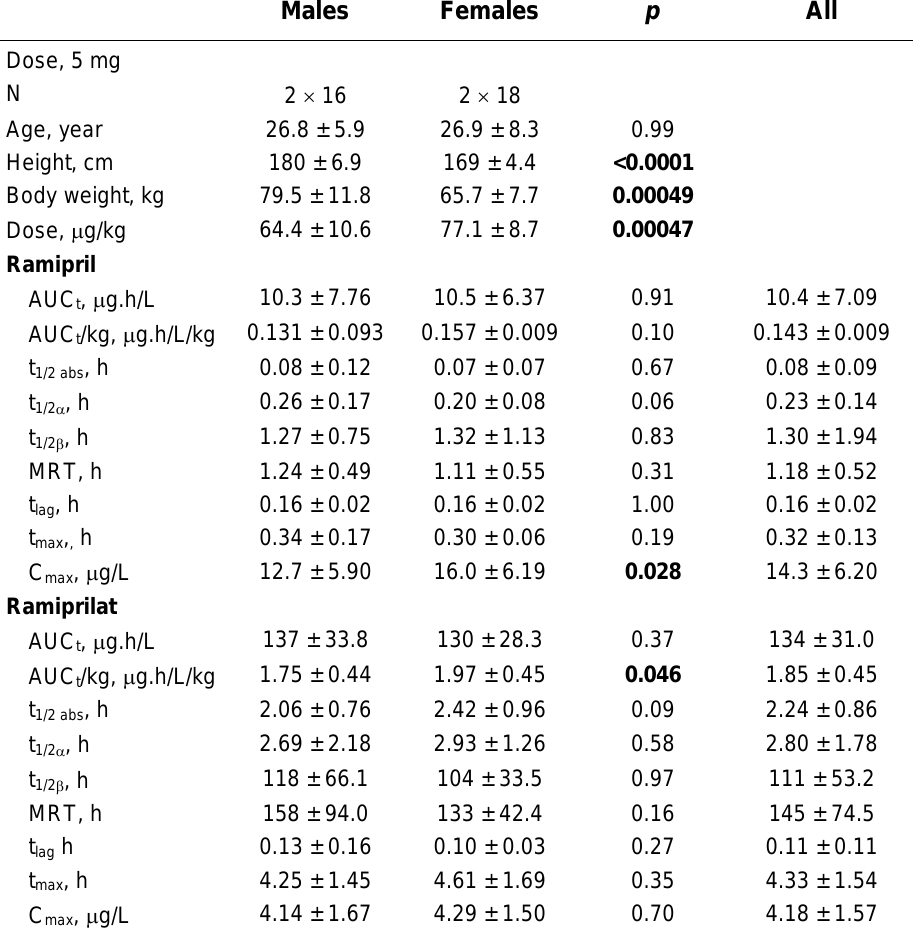
Comparison Between the Pharmacokinetic Parameters of Ramipril and Ramiprilat (Formulation I + II) in Males and